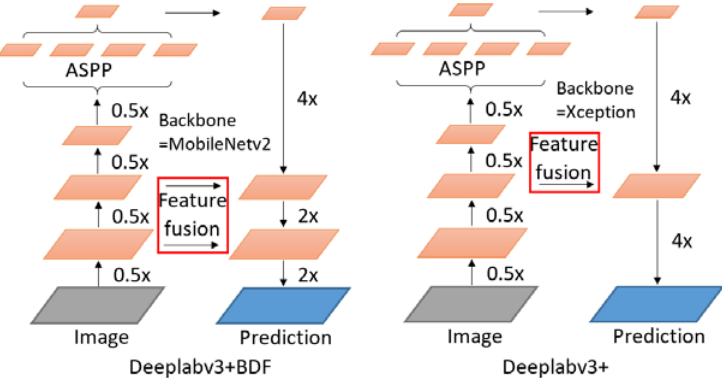
Figure 3. Comparison of network structure changes.